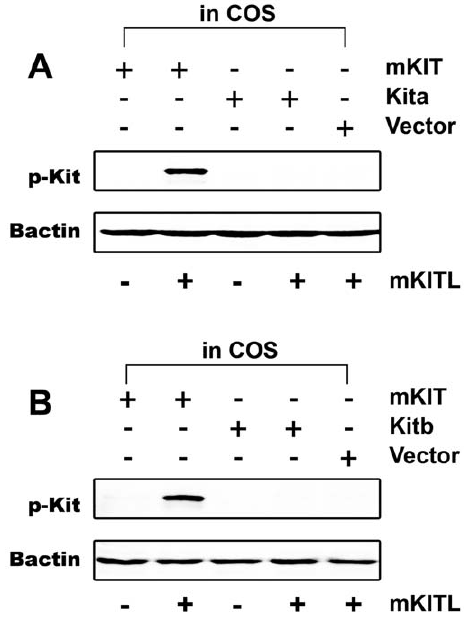
Figure 2. Species specificity of Kit activation by Kit ligand. Plasmids expressing mouse KIT (mKIT), zebrafish Kita (A) or Kitb (B) were transfected into the COS-1 cells. After treatment with recombinant mouse KITL (mKITL) for 10 min, the phosphorylation of Kit was detected by an antibody recognizing the tyrosine phosphorylation site in the intracellular domain. Plasmid pCMV-Script (Vector) was used as a negative control. Bactin was used as the internal control for all samples. p-Kit, Kit phosphorylation; + , recombinant ligand proteins were added or cells were transfected with specific receptor plasmids; 2 , no recombinant ligands or transfection with receptor plasmids.